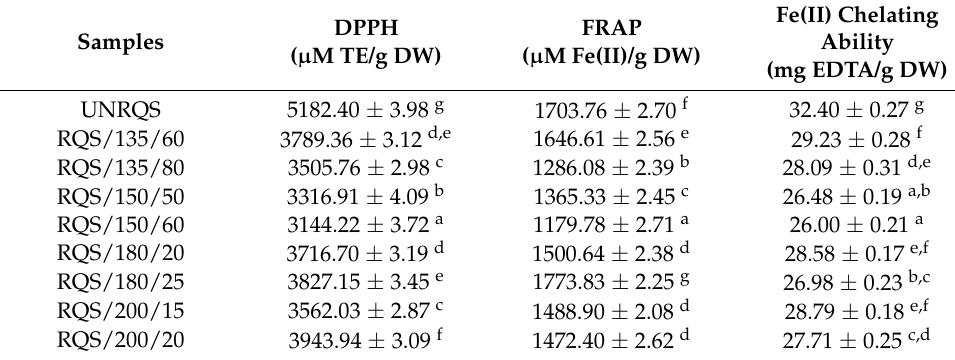
Table 1. Antioxidant properties of Q. rubra seeds before and after roasting.